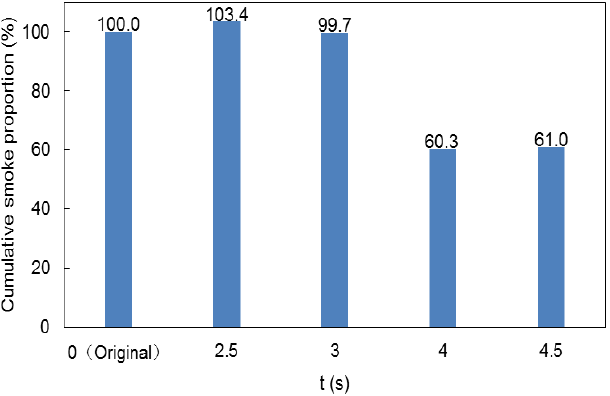
Figure 7. Effect of different EGR valve reopened time on cumulative smoke proportion.